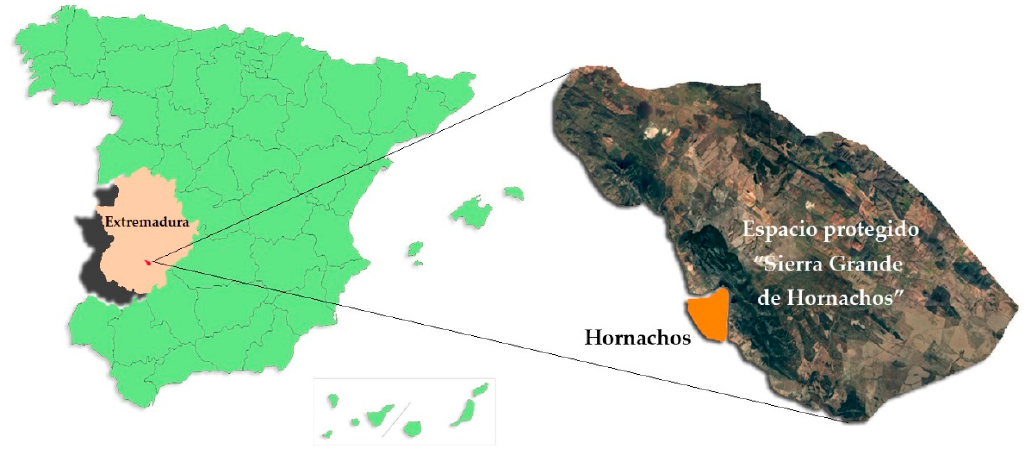
Figure 1. Location of the town of Hornachos and the protected area “Sierra Grande de Hornachos” in Extremadura, Spain.